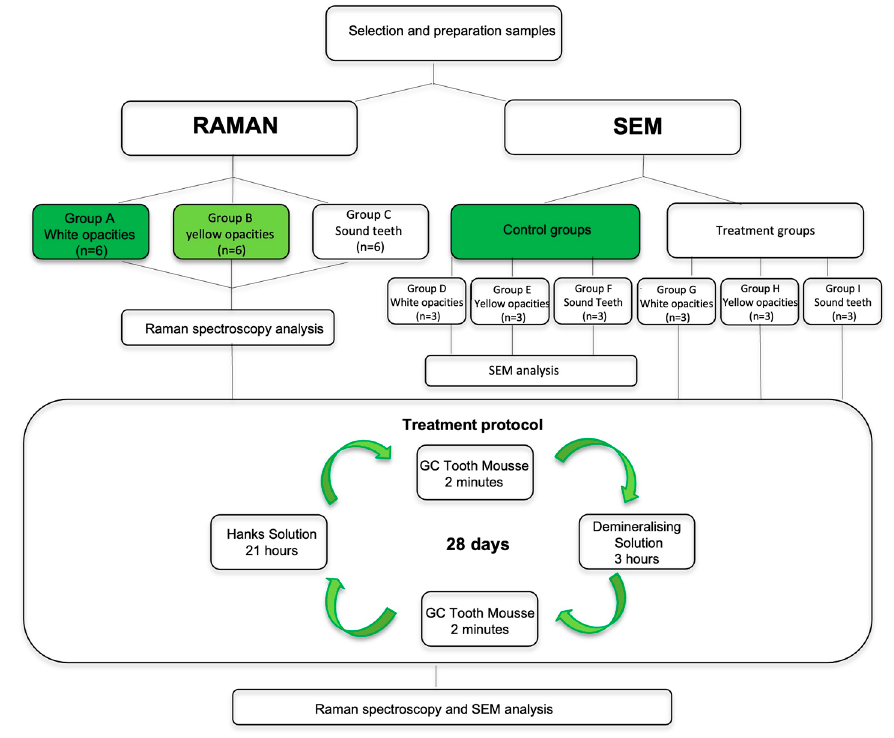
Figure 1. Scheme of the study